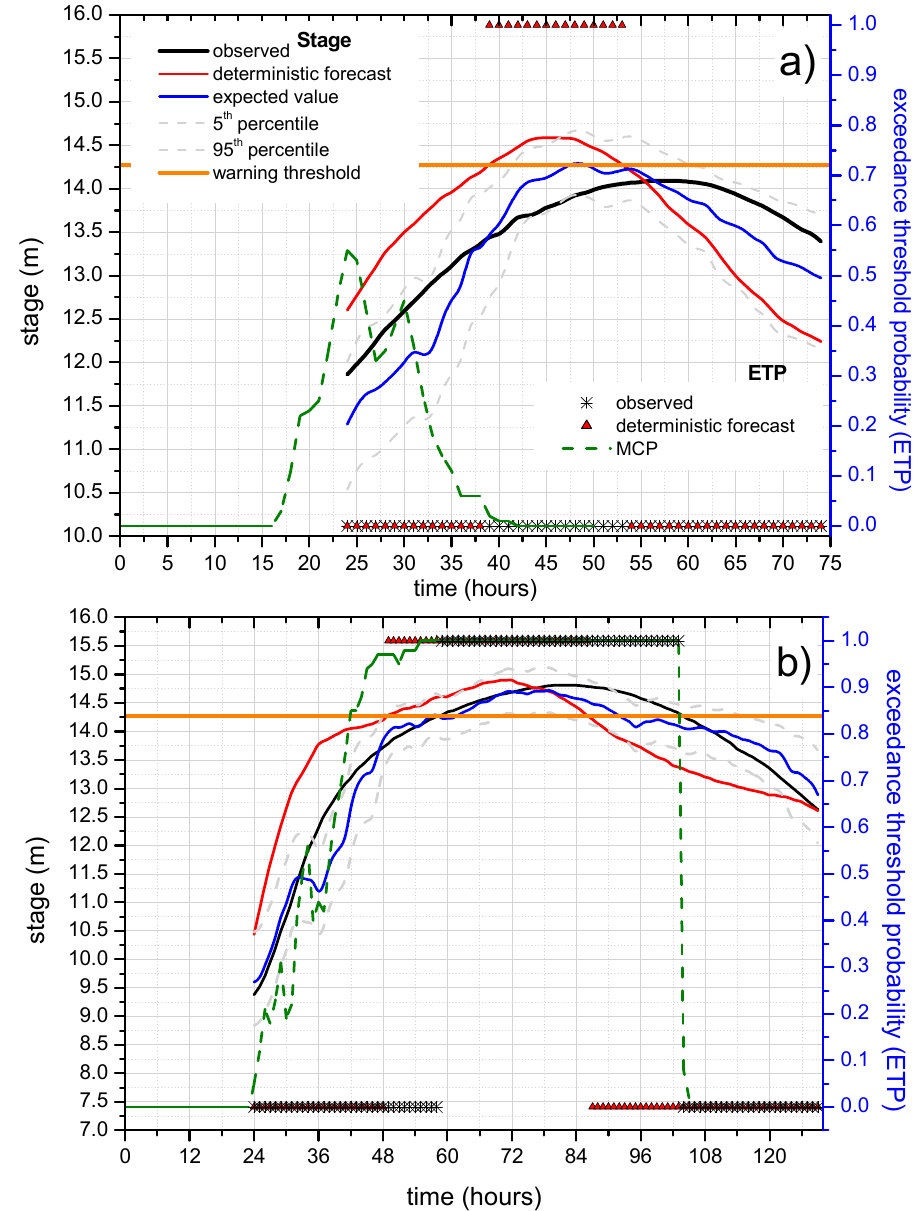
Figure 11. Polavaram section (lead ‐ time 24 h): overtopping warning threshold exceedance probability within the following 24 h estimated by MCP ‐ MT (the threshold exceedance probability at time t refers to the interval t – t + 24 h) for the flood occurred on: ( a ) 21–22 August 2001; and ( b ) 6–10 August 2010. The comparison between deterministic and probabilistic stage forecasts is also shown along with the observed occurrences.